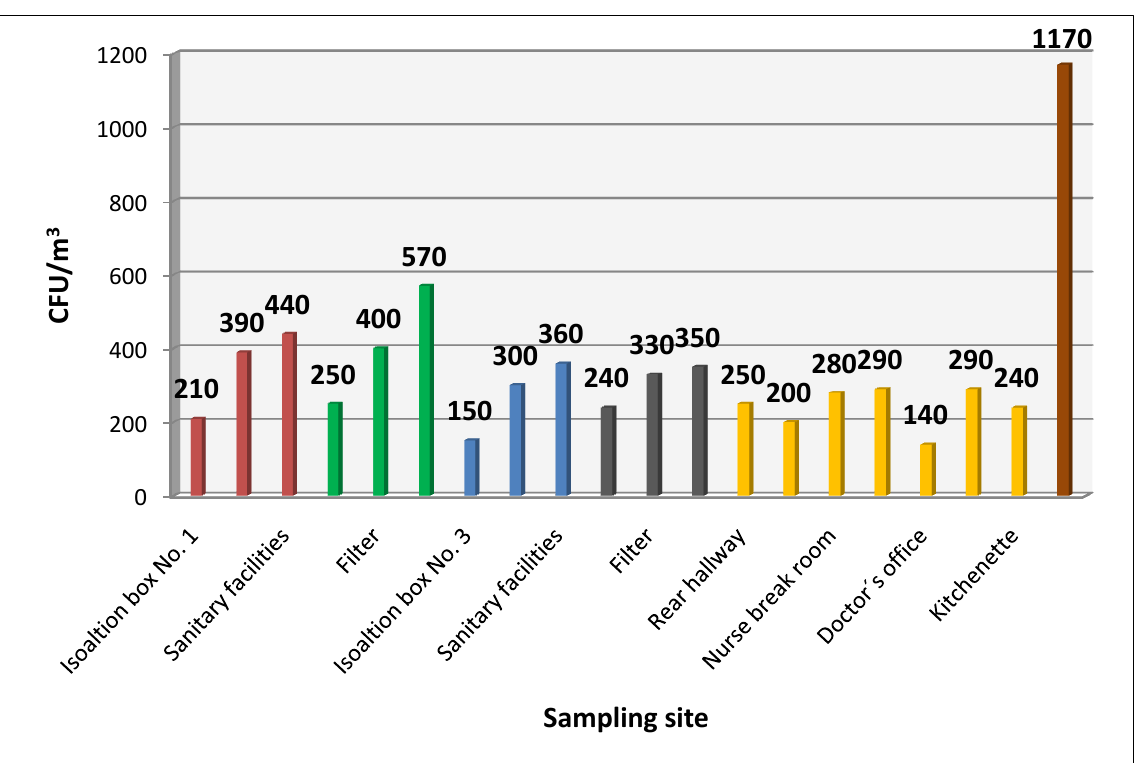
Figure 1. Average CFU/m 3 at sampling sites.